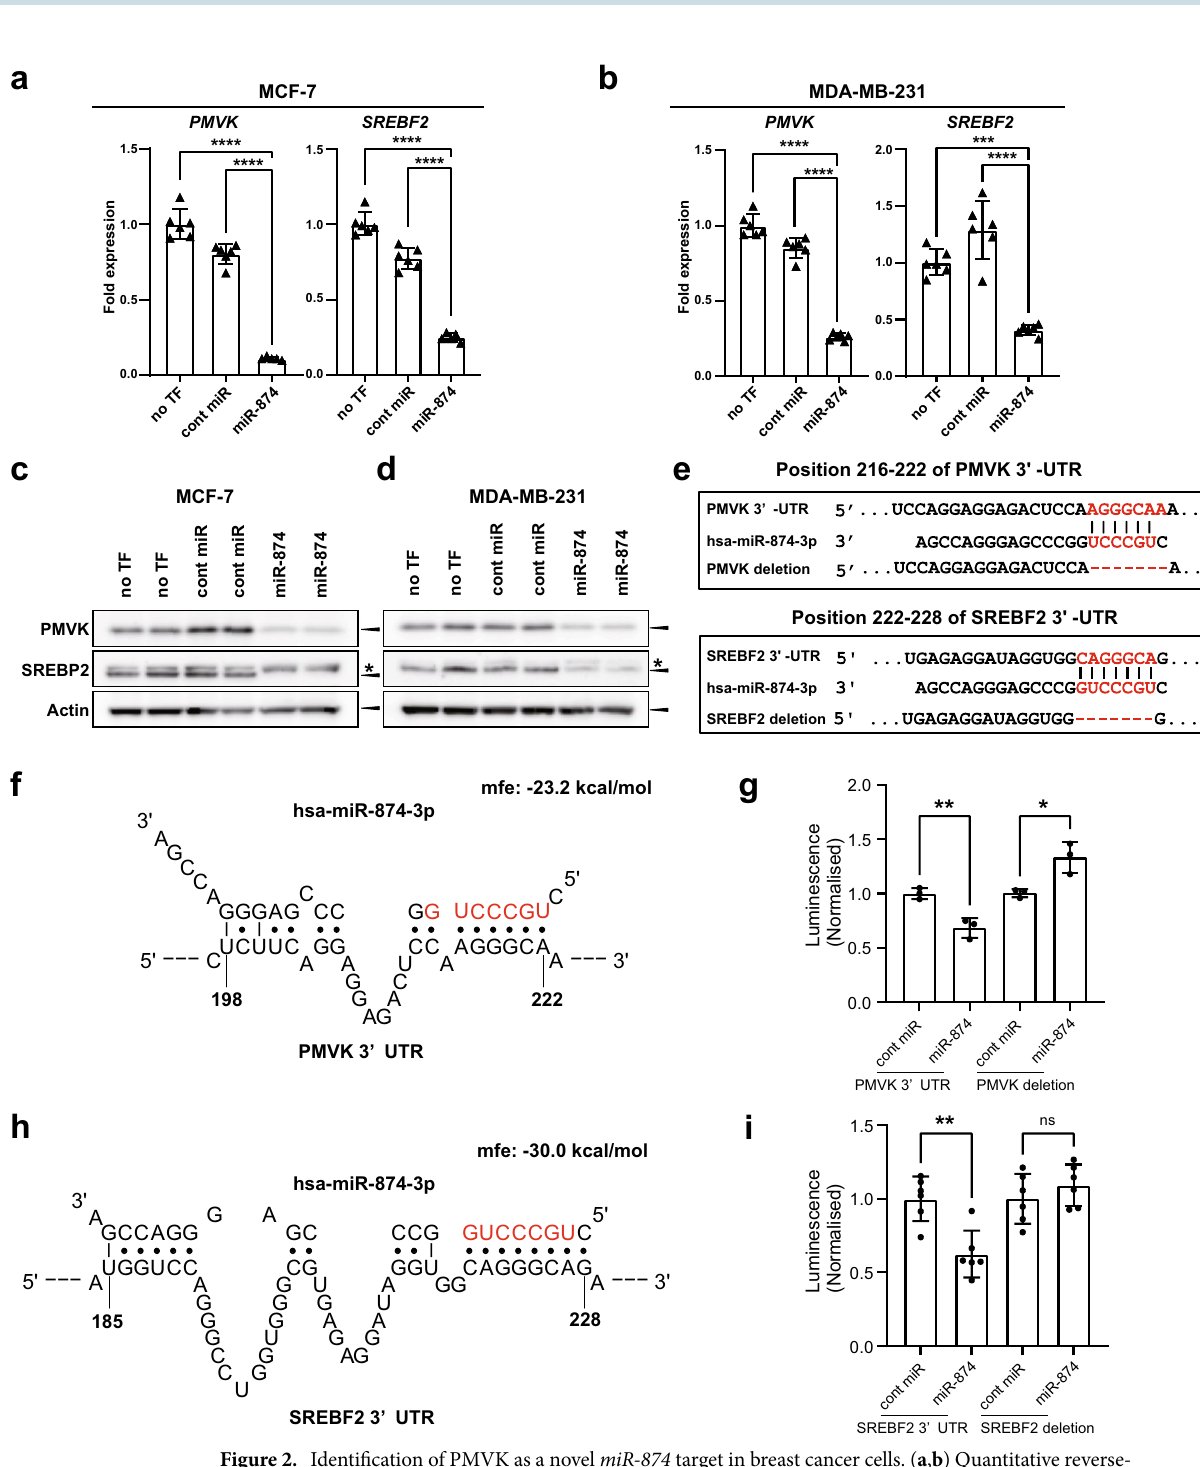
Figure 2. Identification of PMVK as a novel miR-874 target in breast cancer cells. ( a , b ) Quantitative reverse- transcription polymerase chain reaction (qRT-PCR) assays were used to analyse the effects of miR-874 on PMVK mRNA and SREBF2 mRNA in MCF-7 and MDA-MB-231 cells. Data are presented as the mean ± SD. ***p < 0.001, ****p < 0.0001 (one-way ANOVA). ( c , d ) Western blotting for PMVK, SREBP2, and actin in MCF-7 and MDA-MB-231 cells transfected with cont miRNA or miR-874 for 72 h. Triangles indicate specific bands, and asterisks indicate nonspecific bands. ( e ) Bioinformatic analysis using TargetScan predicted that miR-874 might target both the PMVK 3 ′ -UTR and the SREBF2 3’-UTR. ( f ) Putative miR-874 sites in the 3 ′ -UTR of PMVK, as determined by the STarMir program. ( g ) p53/c-Myc double-knockout (DKO) MCF-7 cells were transfected with the PMVK 3 ′ -UTR in a vector construct and miR-874 or control (cont) miRNA to analyse the effects on luciferase activity in the psiCHECK-2- PMVK-3 ′ -UTR reporter. n = 3. Data are presented as the mean ± SD. *p < 0.05, **p < 0.01 (Student’s t test). ( h ) Putative miR-874 sites in the 3 ′ -UTR of SREBF2, as determined by the STarMir program. ( i ) p53/c-Myc DKO MCF-7 cells were transfected with the SREBF2 3 ′ -UTR in a vector construct and miR-874 or cont miRNA to analyse the effects on luciferase activity in the psiCHECK-2-SREBF2-3 ′ -UTR reporter. n = 6. Data are presented as the mean ± SD. **p < 0.01 (Student’s t